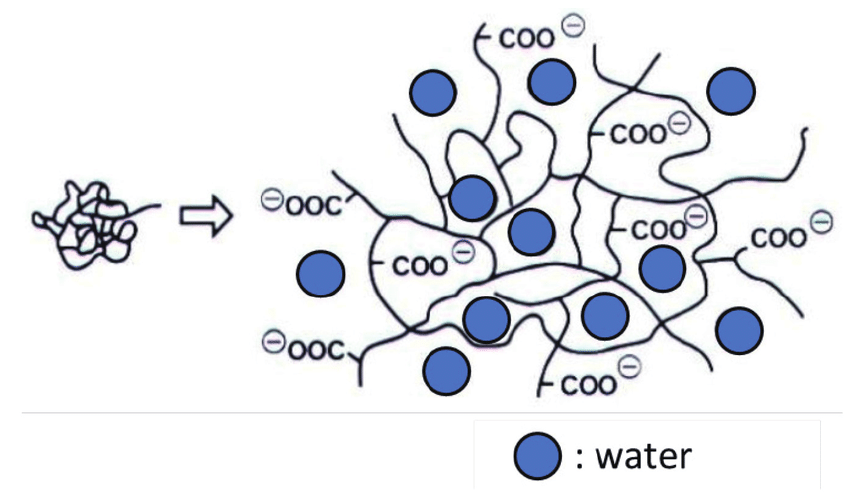
Figure 2. Water absorbing mechanism of superabsorbent